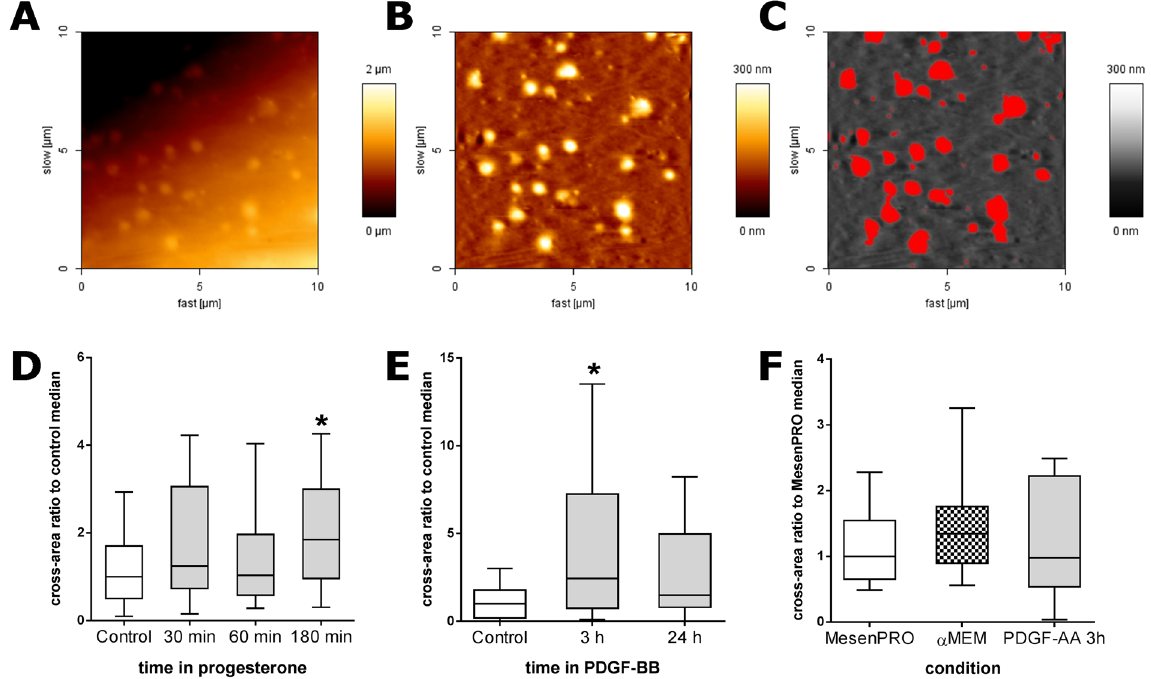
Figure 5. Effect of different treatments or conditions on the amount of membrane protrusions. ( A ) AFM raw topographic image of a 10 × 10 µ m area on the surface of an ADSC (this example corresponds to a cell under progesterone treatment for 30 min). ( B ) The same area after flattening, as described in the methods section. ( C ) Cross-sectional areas of protruding elements at 50 nm height above the mean cell surface, in red; these areas were used for quantifying the amount of protrusions in different culture conditions, as shown in ( D – F ). ( D ) Early effects of the addition of 0.5 mM progesterone (n = 30). ( E ) Effect of the addition of 10 ng/ml PDGF-BB at 3 h or 24 h (n = 20). ( F ) Effect of culturing on basal medium without serum ( α MEM) or of treating the cells with PDGF-AA (n = 10). Tukey’s box and whiskers plots, where the central line represents median values, boxes represent the interquartile range (IQR) and whiskers extend to the extreme values within 1.5 times the IQR. Values have been normalized by dividing by the median of their respective controls (cells maintained in MesenPRO medium in each experiment). In D and E, Kruskal-Wallis one-way analysis of variance showed statistically significant differences (P < 0.05). Asterisks ( * ) mark the treatments where differences with respect to controls were detected (post-hoc Dunn’s test, P <